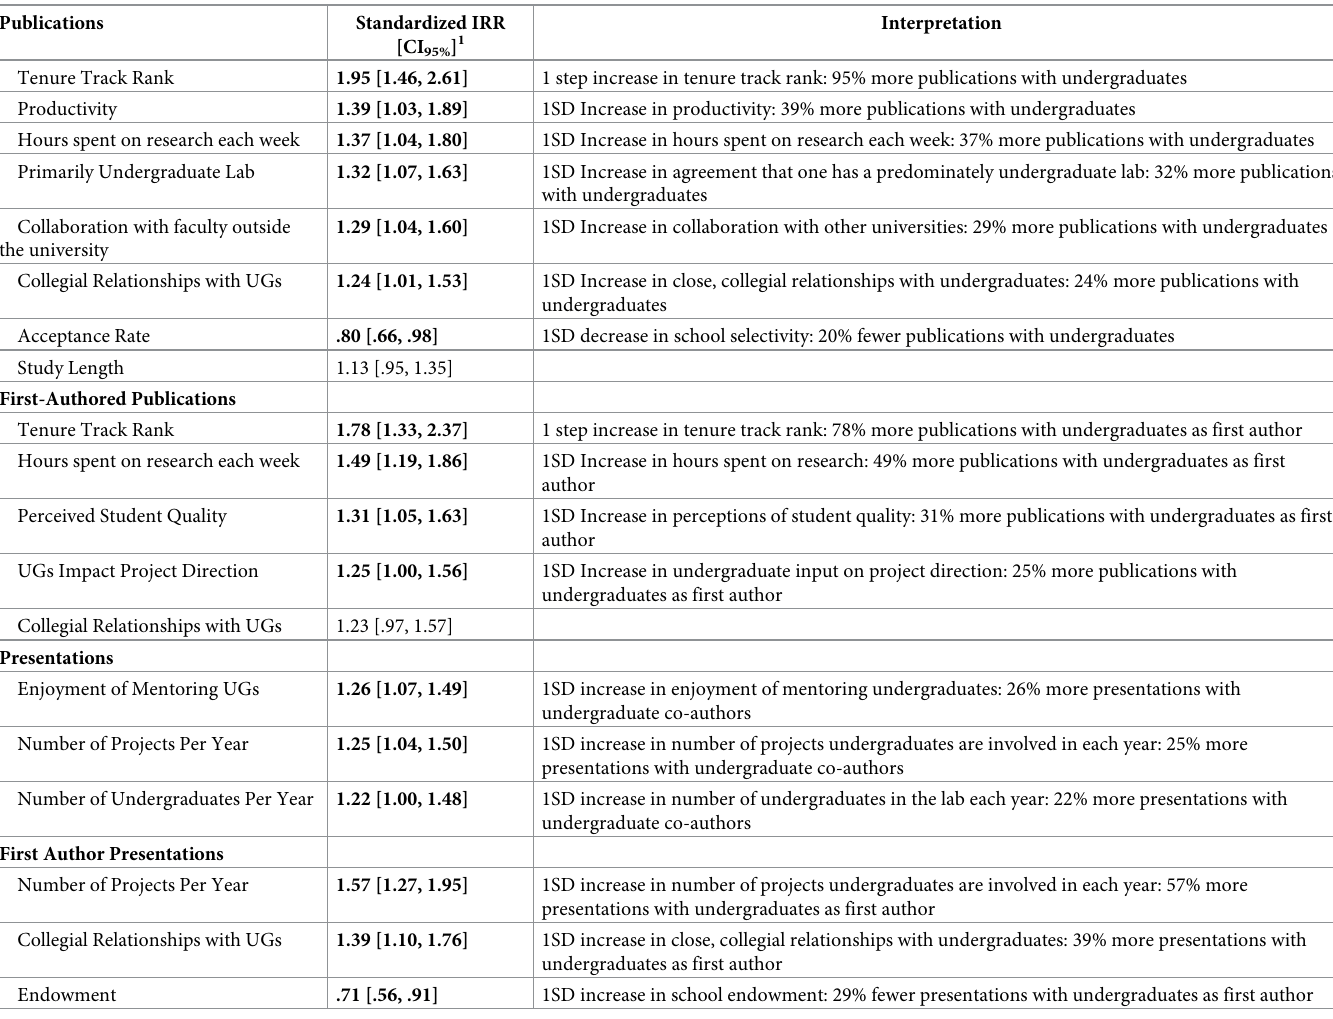
Table 5. Negative binomial regressions from the final model in a series of backward-elimination stepwise